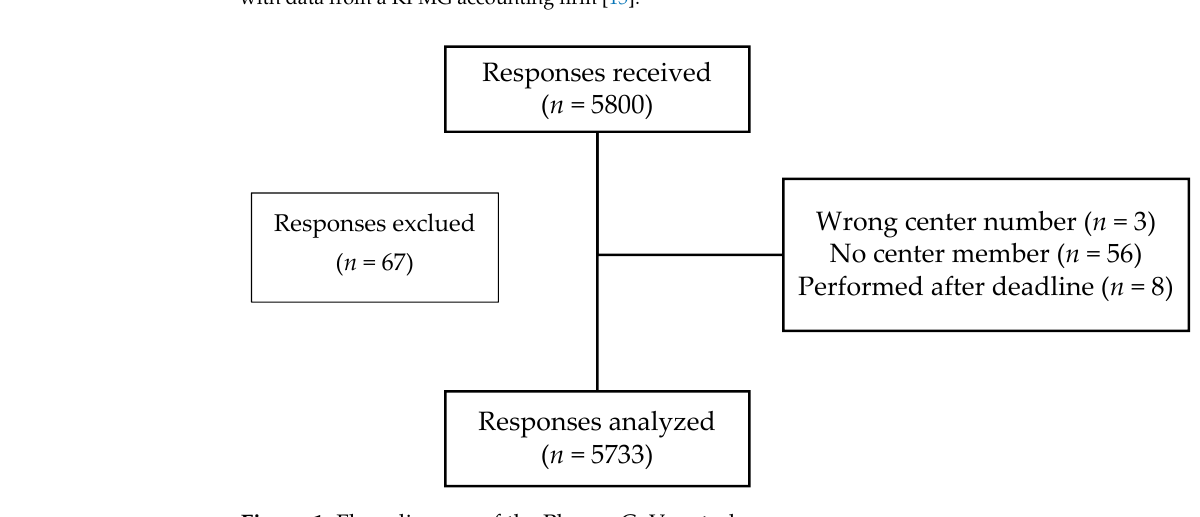
Figure 1. Flow diagram of the PharmaCoVax study.